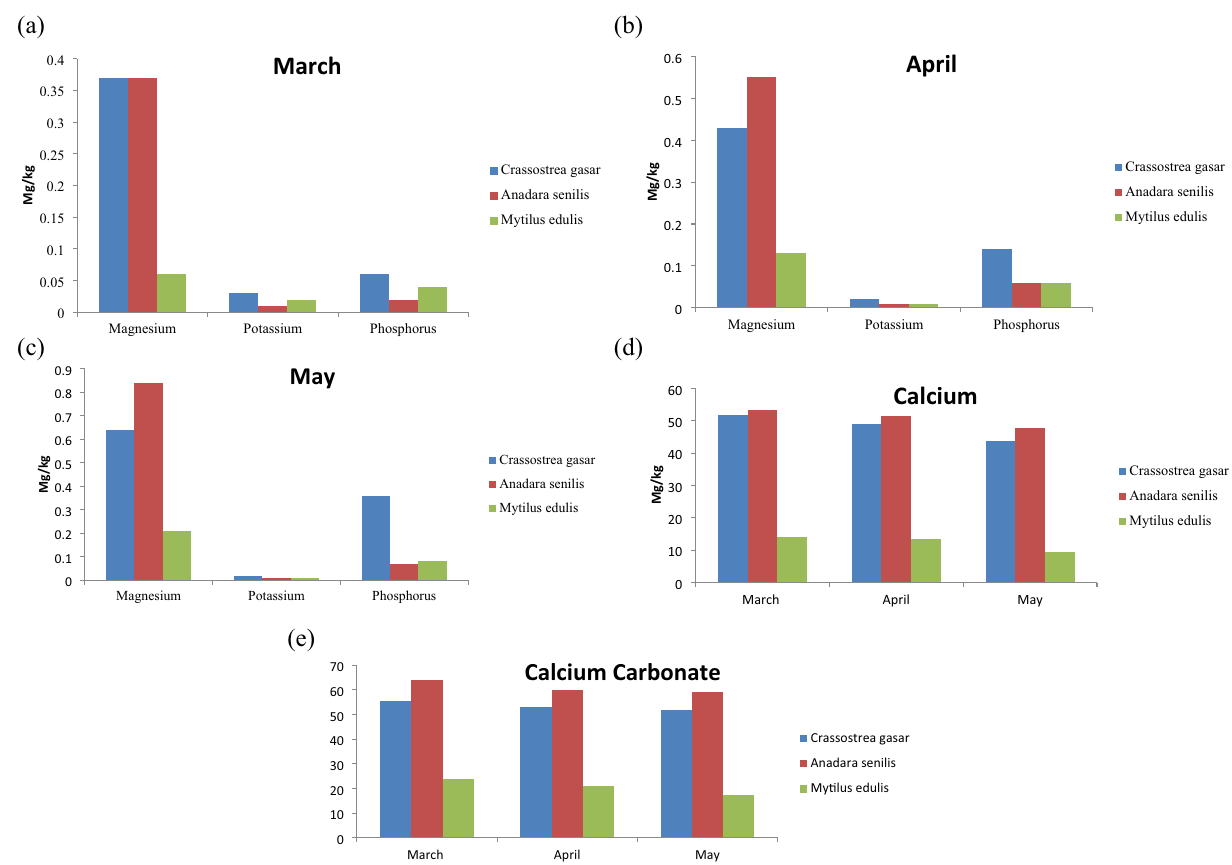
March, April, and May 2021, e CaCO content in Crassostrea gasar , 3 Anadara senilis , and Mytilus edulis in